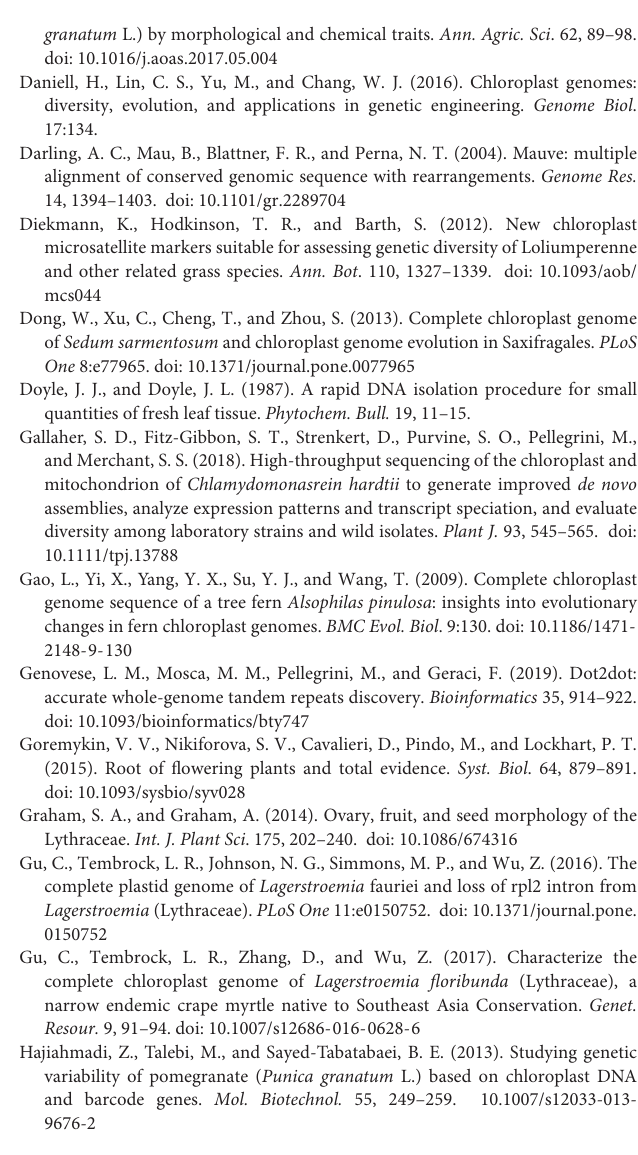
Supplementary Figure 1 | Genome map of all cp genomes of pomegranate. Supplementary Table 1 | Frequency and distribution of repeats and SSR motifs in Punica granatum cp genomes. Supplementary File 1 | GenBank files of all pomegranate chloroplast genomes. Supplementary File 2 | Mutations in all Punica cp